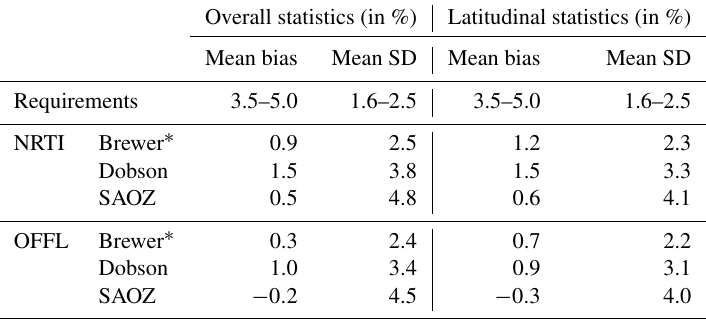
Figure 11. The dependency of the percentage differences of the two TOC products on cloud top pressure (a) and cloud base height (b) . Table 2. Statistical analysis of the overall (global) and the latitudinal mean bias and mean standard deviation of the NRTI and the OFFL TOC